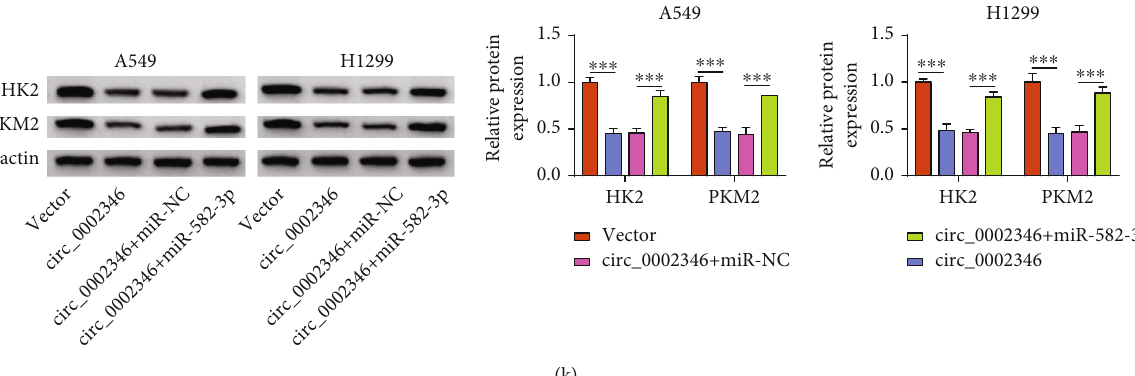
Figure 4: circ_0002346 overexpression-induced antitumor impacts are partly reversed by the addition of miR-582-3p mimics in NSCLC cells. (a) The transfection e ffi ciency of miR-582-3p mimics in NSCLC cells was analyzed by RT-qPCR. (b – k) NSCLC cells were transfected with circ_0002346 alone or together with miR-582-3p mimics. (b, c) Cell proliferation ability was measured by an EDU assay and a colony formation assay. (d, e) Cell migration and invasion abilities were analyzed by transwell assays. (f) The apoptosis rate (FITC + and PI +/- ) of NSCLC cells was assessed by fl ow cytometry. (g) Cell apoptosis was analyzed by measuring caspase3 activity using a caspase3 activity assay kit. (h) The protein expression of Bax and C-casp3 was detected by a Western blot assay. (i, j) The consumption of glucose and the level of lactate were analyzed using a fl uorescence-based glucose/lactate assay kit. (k) The protein levels of HK2 and PKM2 were detected by a Western blot assay. ∗∗ P < 0 : 01 ; ∗∗∗ P < 0 : 001